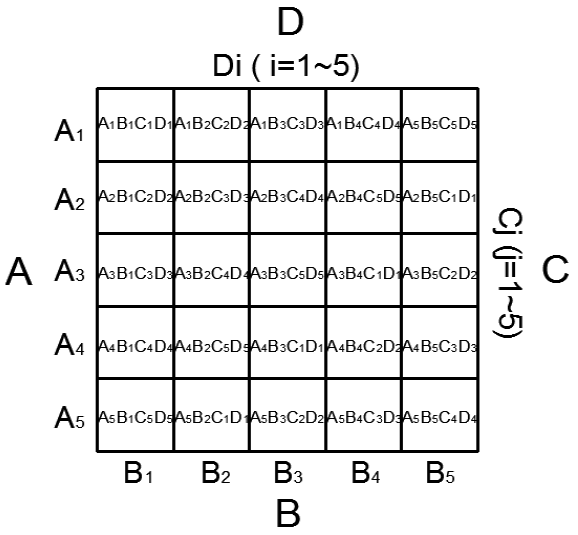
Figure 6. Experimental scheme of the four factors and five